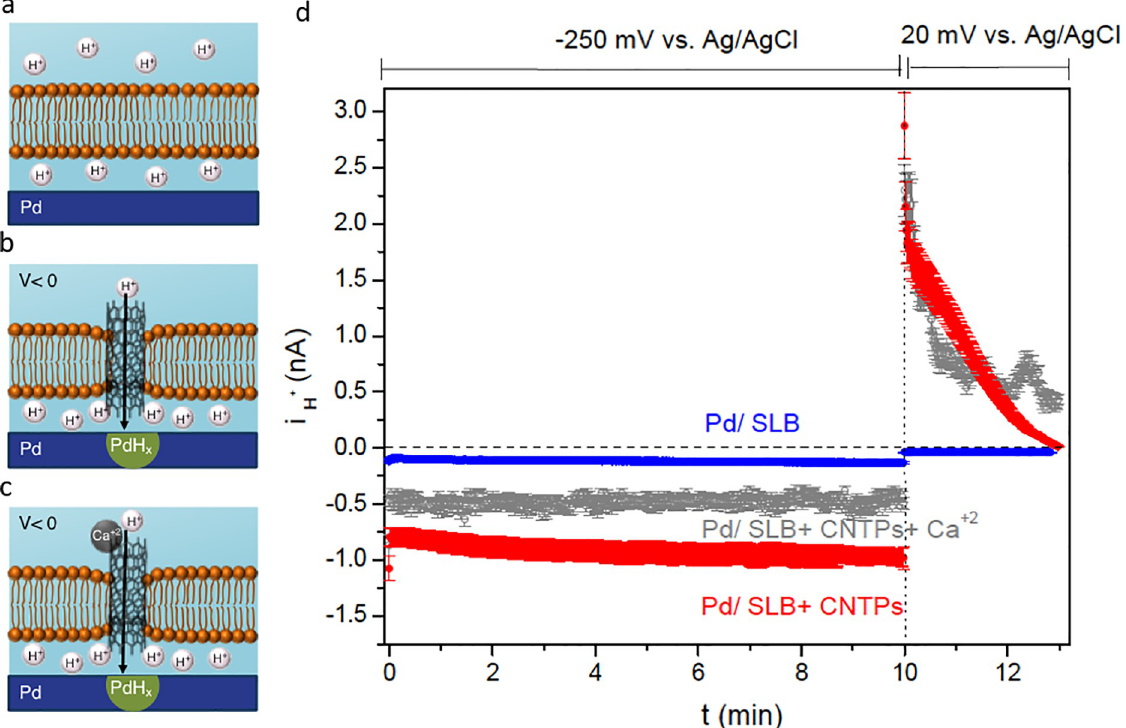
Fig 2. ( a ) Pd contact with SLB. The SLB blocks H + from transferring from the solution to the Pd contact even with V = -250 mV (vs. Ag/ AgCl). ( b ) Pd contact with SLB incorporating 0.8 nm diameter CNTPs is semipermeable to H + , with CNTPs facilitating the rapid flow of H + to the Pd/solution interface. ( c ) Upon addition of Ca +2 to the bulk solution, H + current through CNTPs becomes partially blocked. (d) i H+ vs. time plots recorded at V = − 250mV and V = 20 mV. Blue trace: SLB, red trace: SLB with CNTPs, gray trace SLB with CNTPs in presence of Ca +2 ions in the bulk solution. (The data are collected from 3 different devices with different dimensions: Pd / SLB: 3 different devices of 2 × 50 μ m, Pd/SLB+CNTPs: 3 different devices of 2 × 50 μ m, Pd/SLB+CNTPs+Ca +2 : 3 different devices of 2 × 50 μ m. The error bars are the root mean square of the displacement of the data from the average